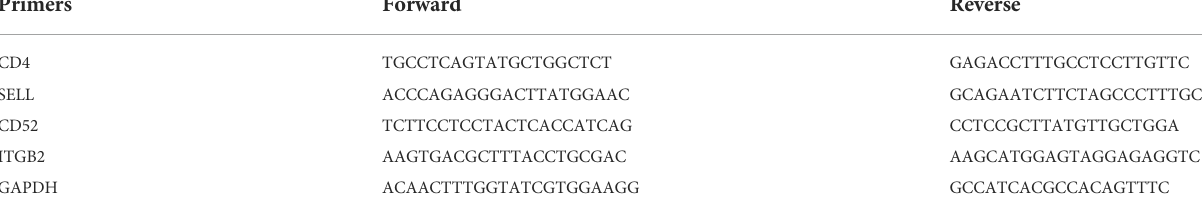
TABLE 2 Primers used for RT-qPCR ampli fi